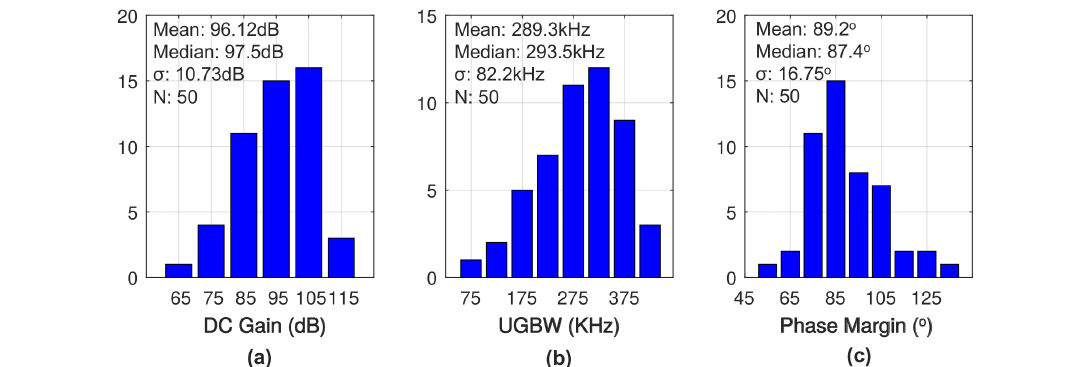
Figure 20. Monte Carlo simulation for ( a ) DC voltage gain ( b ) unity gain bandwidth and ( c ) phase margin of the proposed amplifier with 1-nF load capacitance. Table 6. Performance summary and Figure-of-Merit (FoM) comparison.